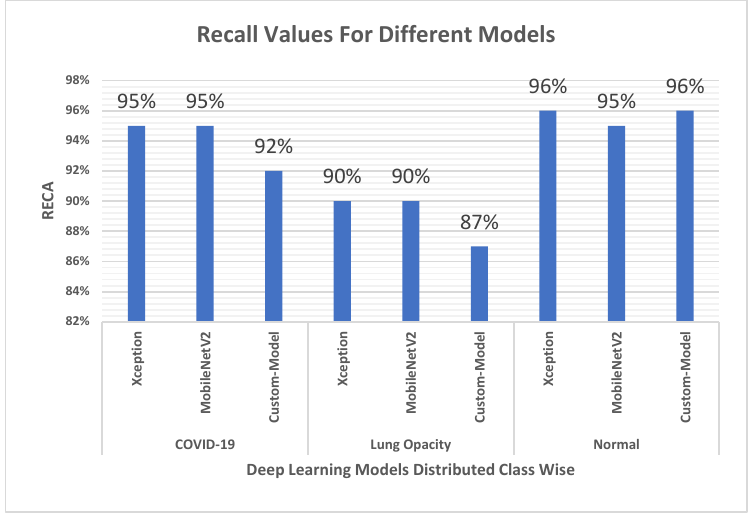
Figure 9. Recall plot for different models in terms of percentages.